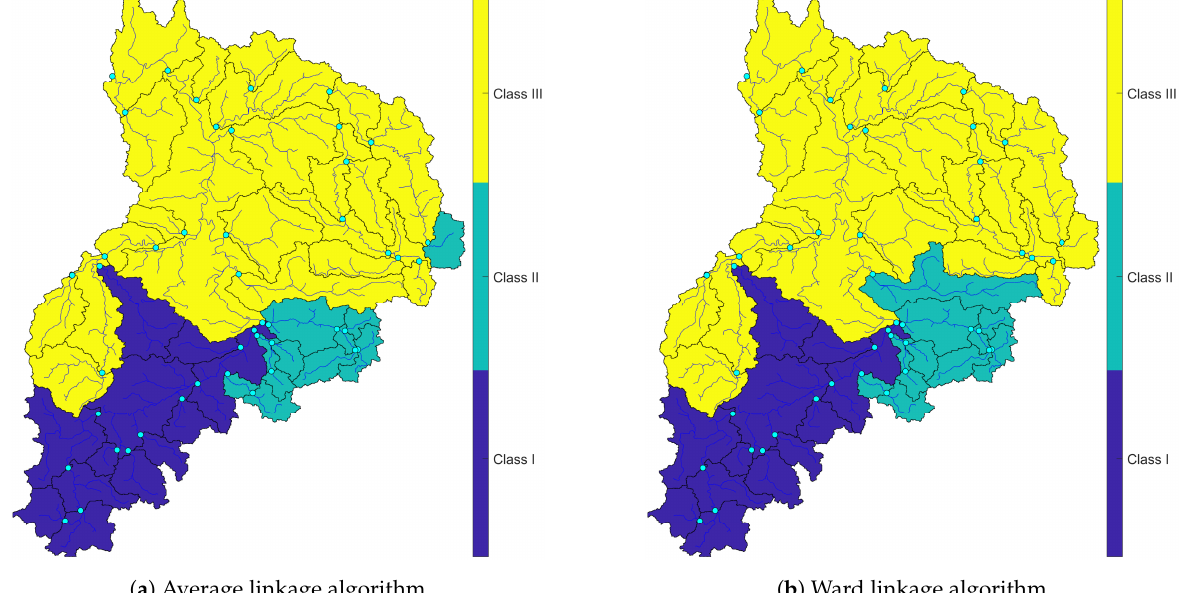
Figure 9. Clustering the simultaneous occurrences of the biggest flood events using Euclidean dist.